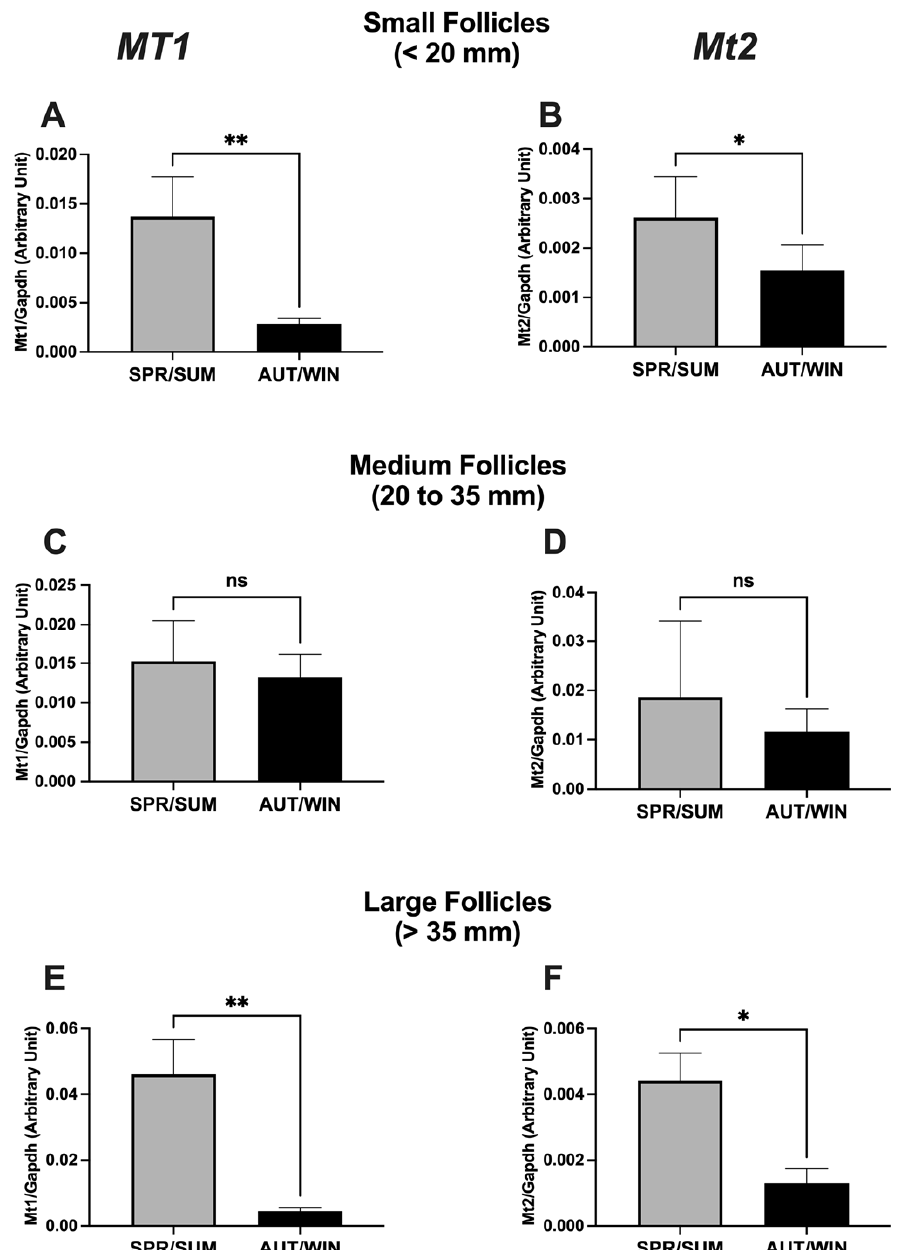
Figure 2. Seasonal distribution of mRNA expression of Mt1 ( A , C , E ) and Mt2 ( B , D , F ) genes in mare ovarian follicles. SPR/SUM: spring and summer; AUT/WIN: autumn and winter. Non-parametric Mann–Whitney test was used to determine significant differences (plotted as mean ± SEM). Asterisks represent season differences (* p < 0.05; ** p < 0.01). ns: non-significant. Reference gene: Gapdh .